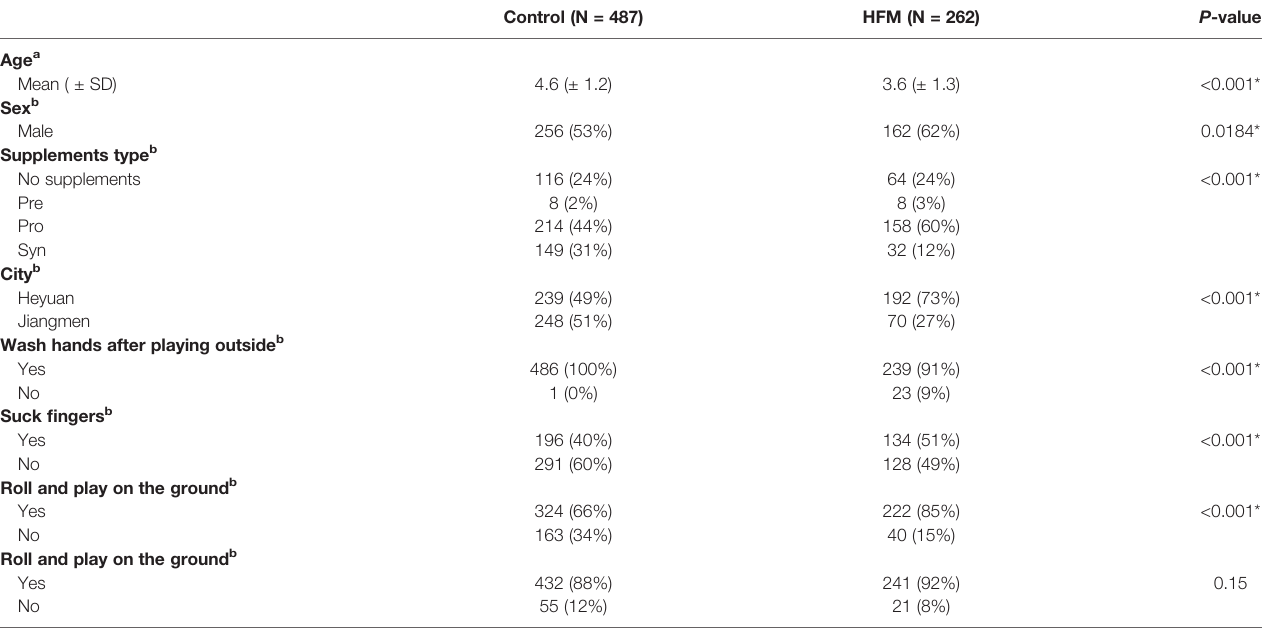
TABLE 1 | Demographic characteristics and probiotics, prebiotics, and synbiotics supplement of the participants.